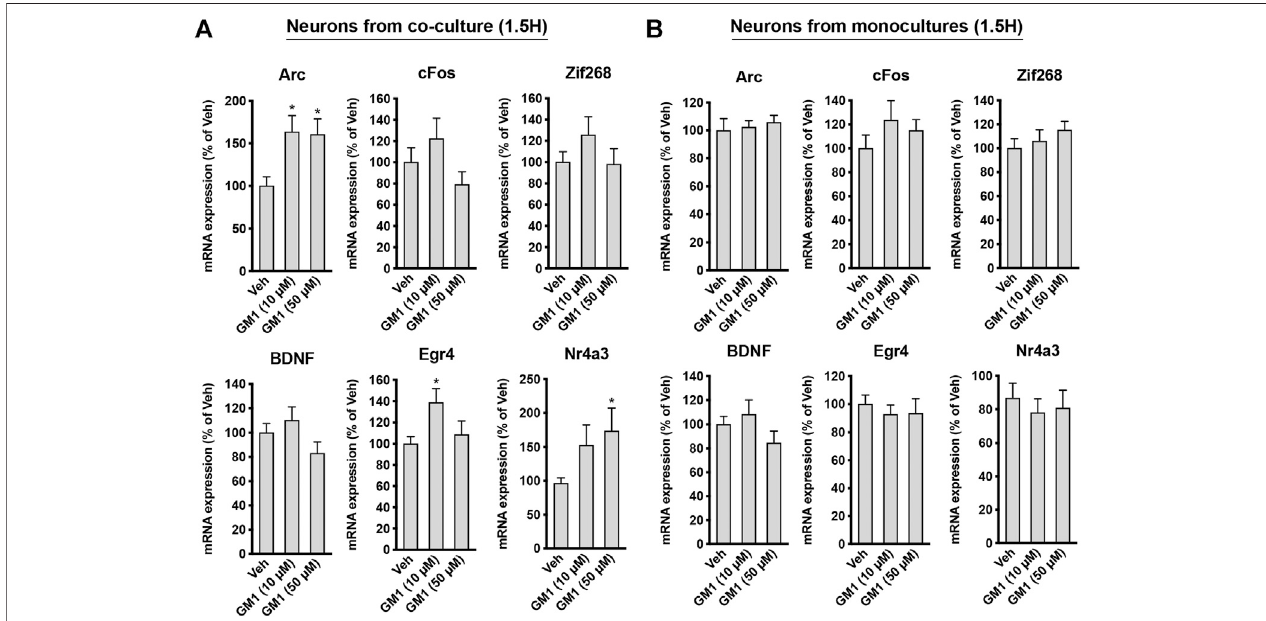
FIGURE 5 | Regulation of plasticity and neuroprotection genes by GM1 in neurons from co-cultures and monocultures. (A,B) mRNA expression of Arc , cFos , Zif268 , Bdnf , Egr4 and Nr4a3 in neurons from astrocyte-neuron co-cultures (A) or from monocultures (B) treated with Veh (DMSO 0.1%) or GM1 (10 and 50 μ M) for 1.5 h. Dataare shown as the average +SEM ofmRNA expression levels represented as% ofVeh ( n (cid:2) 12). Statistical analyses consisted in one-way ANOVA followed by Dunnett ’ s post-hoc test; * p < 0.05, ** p < 0.01, *** p < 0.001.